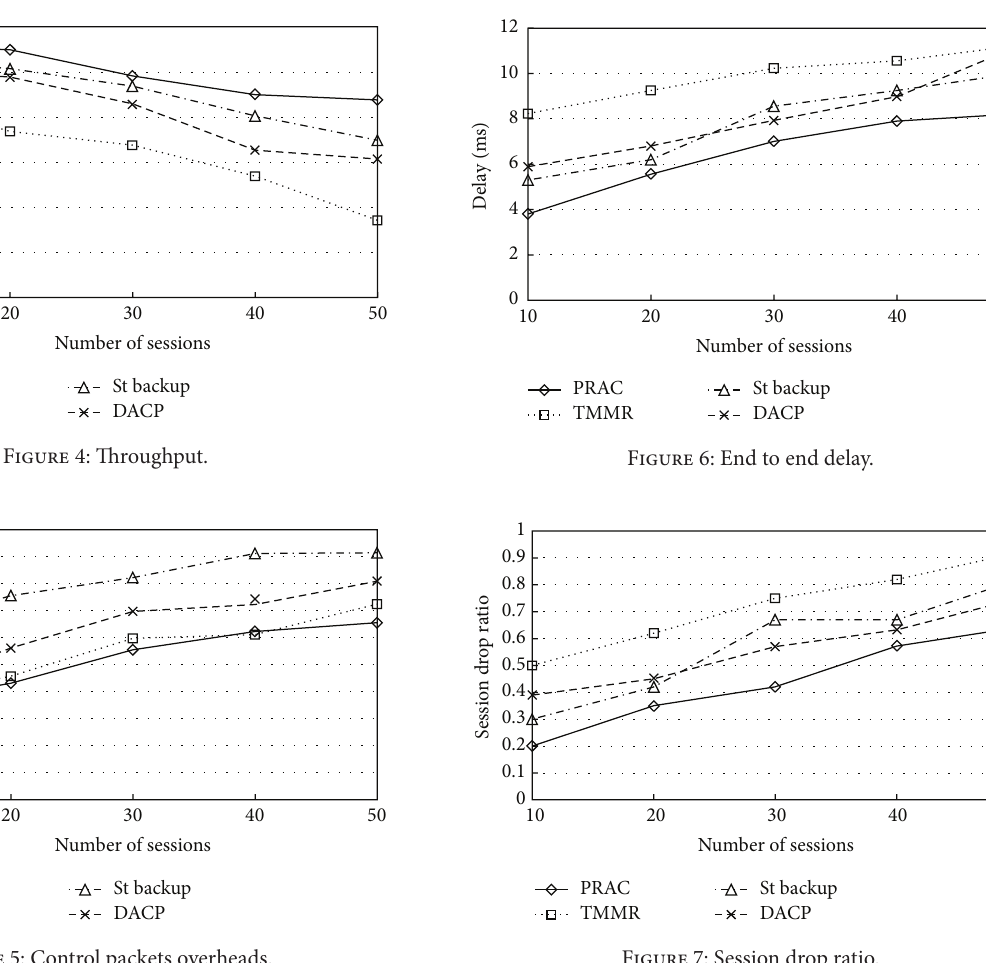
Figure 7: Session drop